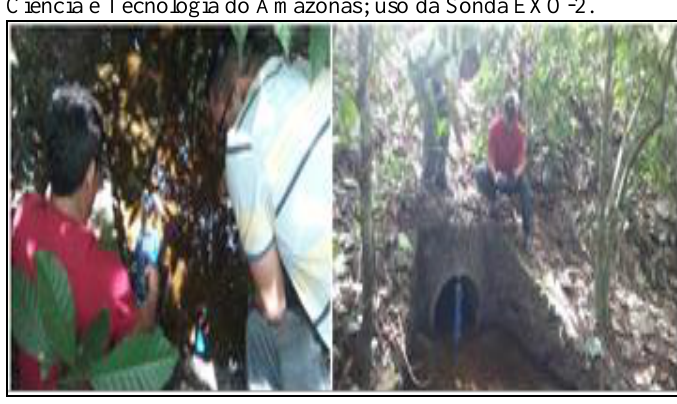
Figura 2: Nascente do Igarapé do Quarenta Fonte: Autores, (2018)